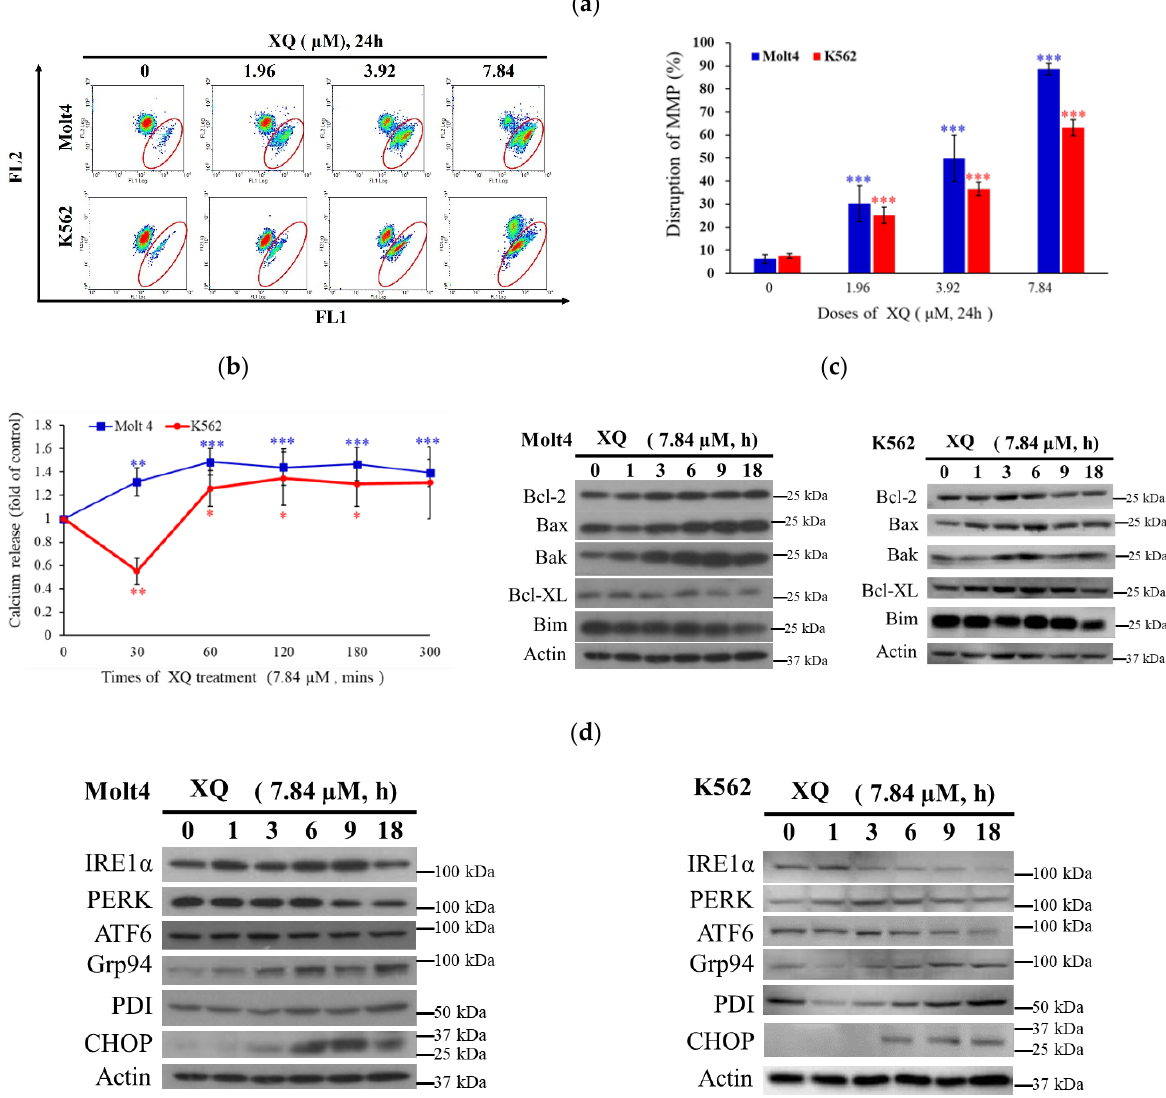
Figure 6. The apoptotic effect of XQ on leukemia cells is mediated through mitochondrial dysfunction and ER stress. Leukemia cells were treated with XQ for 24 h. ( a ) XQ induced changes in MMP that were detected by flow cytometry. ( b ) XQ induced calcium release from ER into the cytosol. ( c ) The leukemia cells were treated with XQ treatment for 24 h and whole-cell lysates were collected. XQ regulated the Bcl-2 family, and the effect was evaluated by Western blotting. ( d ) Leukemia cells were treated with XQ for 24 h and whole-cell lysates were collected. The markers of ER stress were detected by Western blotting. Actin was used as the loading control. The results are presented as means ± SD of three independent experiments; * p < 0.05, ** p < 0.01, and *** p <